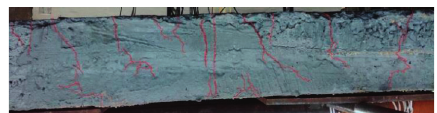
Figure 38: Fracture patterns on LPCSHTHSC along the long-span